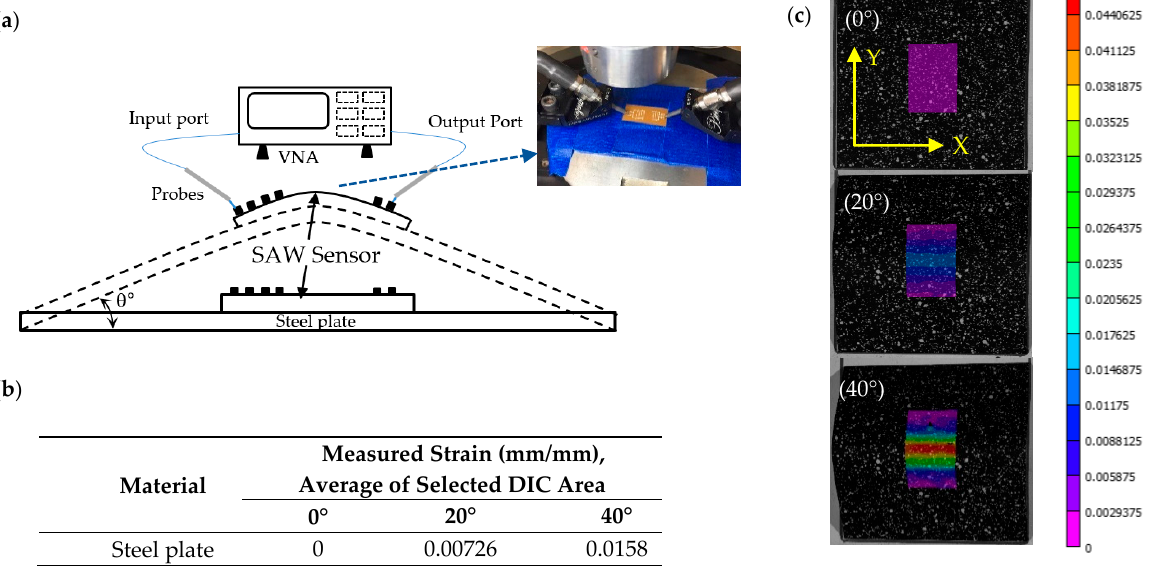
Figure 9. ( a ) VNA test setup with SAW sensor attached to a steel plate bent with angle θ . ( b ) Quantitative average strain measured in sensor area with 0 ◦ , 20 ◦ , and 40 ◦ angles. ( c ) Digital image correlation of displacement in Y direction. Contour ranges: pink indicates low strains; red indicates high